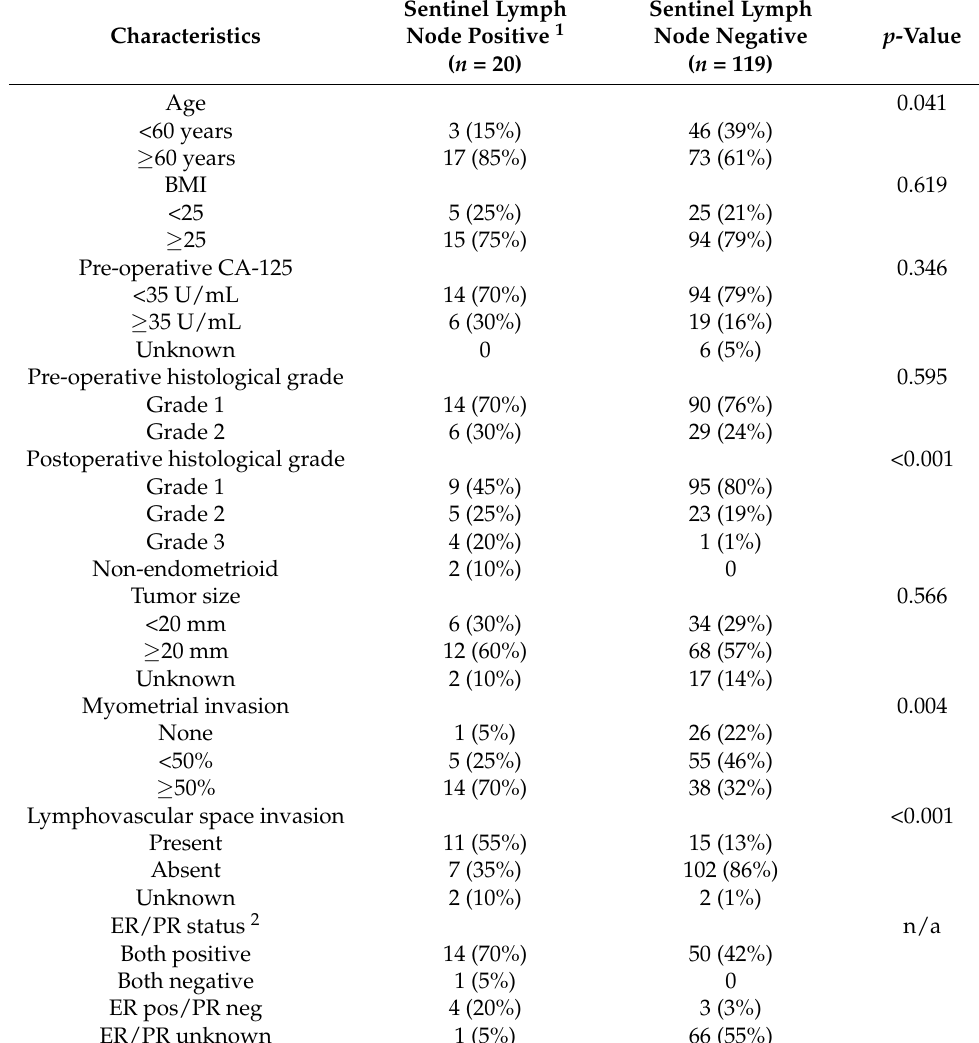
Table 2. Characteristics of the patients with andomized SLN mapping ( n = 139), with and without Sentinel Lymph Node (SLN)